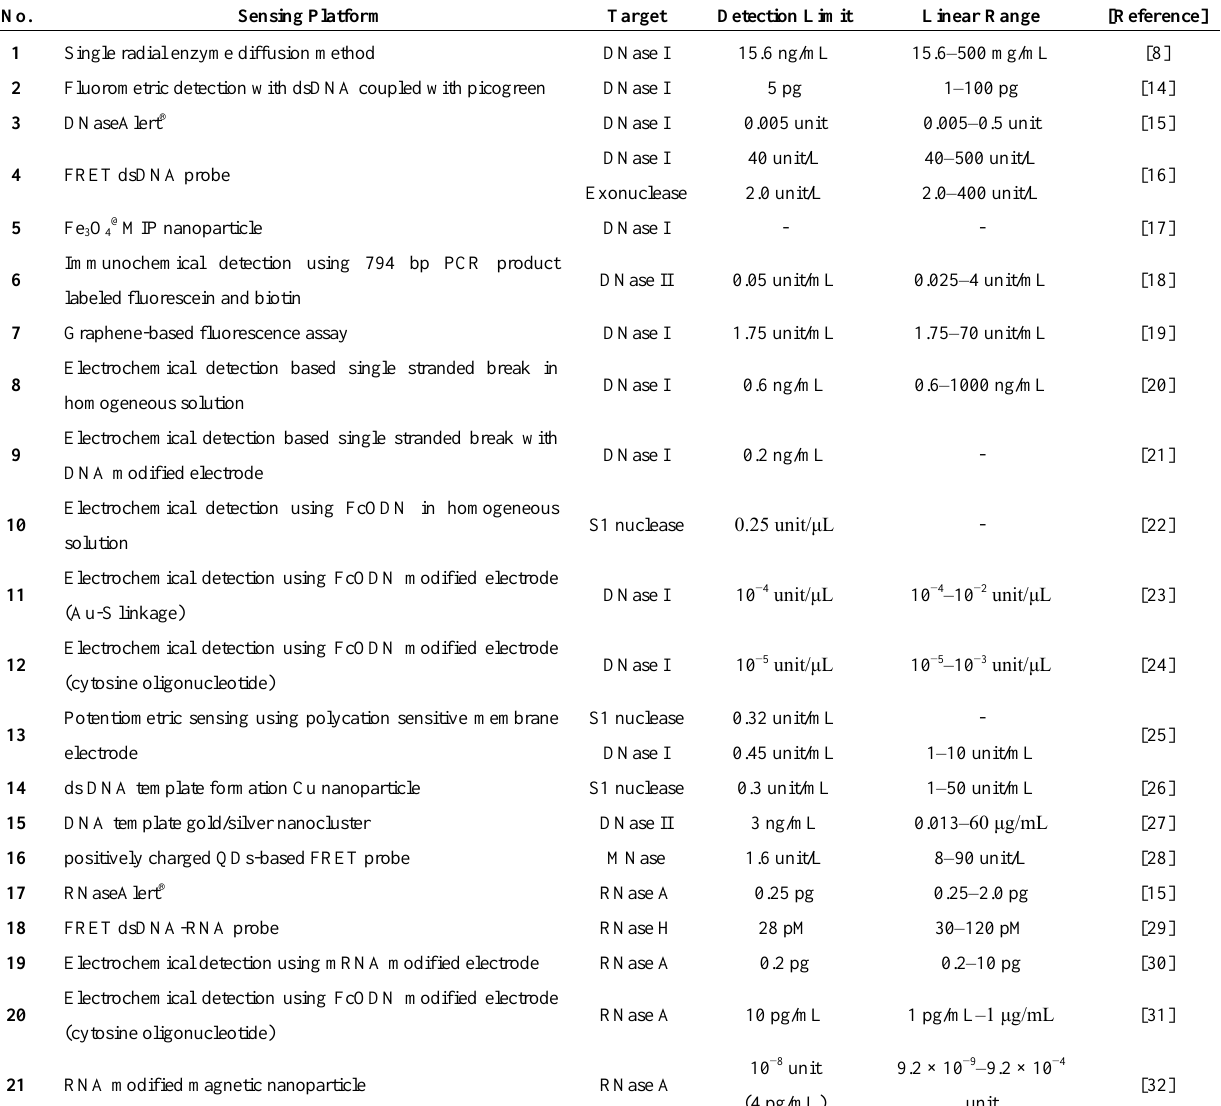
Table 1. Analytical performance of DNase and RNase detection